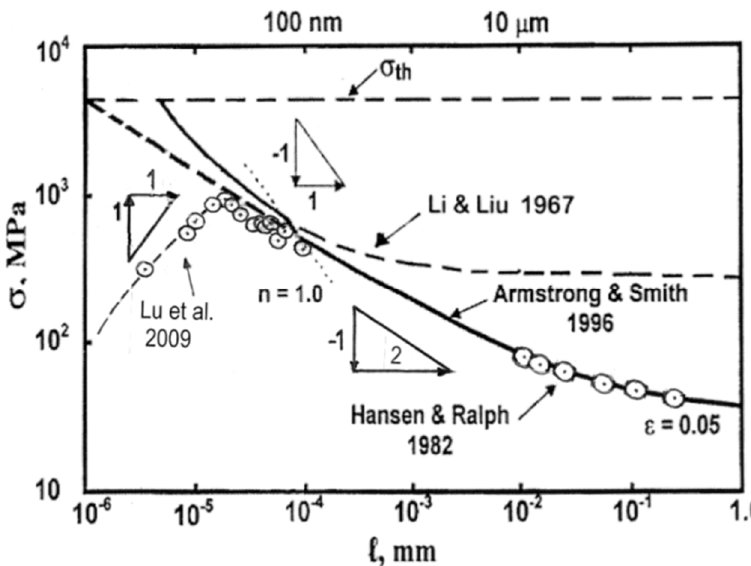
Figure 3. The flow stress dependence on grain size and nano-twin spacing for copper materials also relating to the transition from an (1/ ℓ ) 1/2 to a (1/ ℓ ) dependence at ~100 nm and then to grain size weakening behavior at ~20 nm.